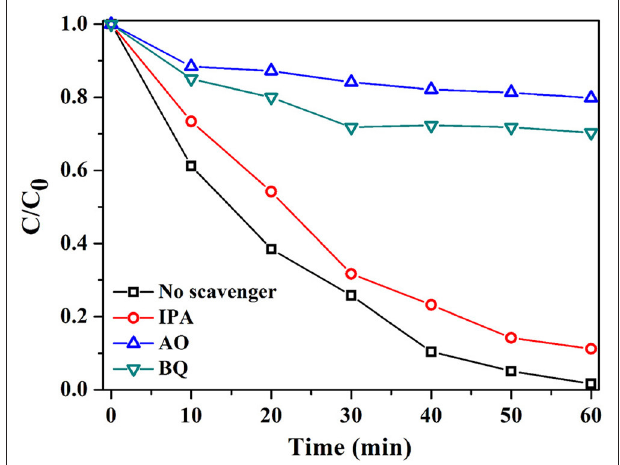
FIGURE 7 | (A) TOC removal rate during RhB degradation with AVO/BOC-10; (B) The cycling performance of AVO/BOC-10. FIGURE 8 | PL spectra of pristine Bi 2 O 2 CO 3 and